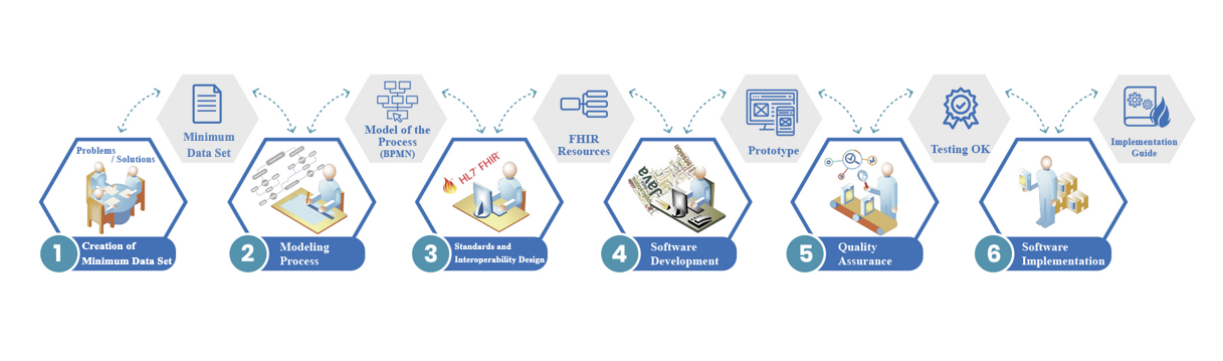
Figure 1. Methodology to design and develop an interoperable software solution. Six well-defined stages with its products and standards involved. BPMN: Business Process Model and Notation; FHIR: Fast Healthcare Interoperability Resources; HL7: Health Level